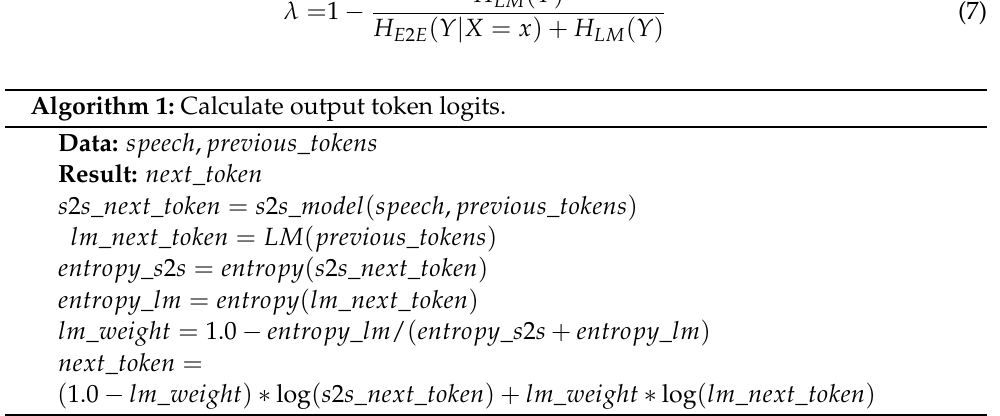
Algorithm 1: Calculate output token